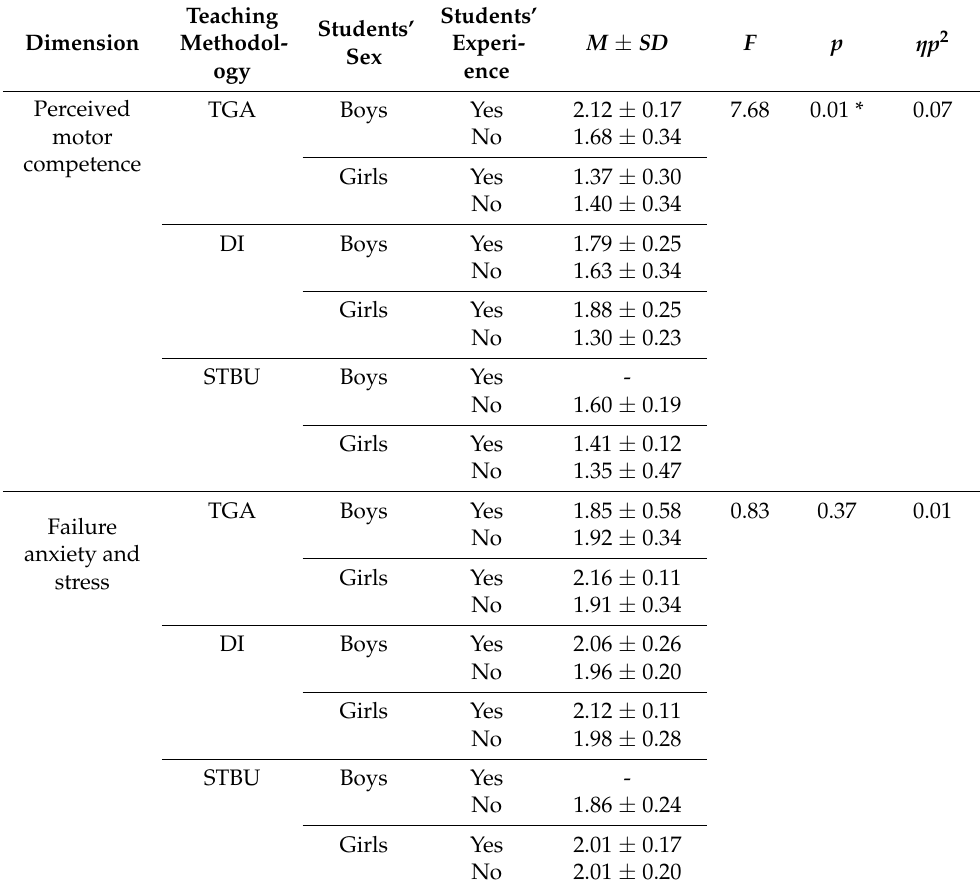
Table 4. Cont . Dimension